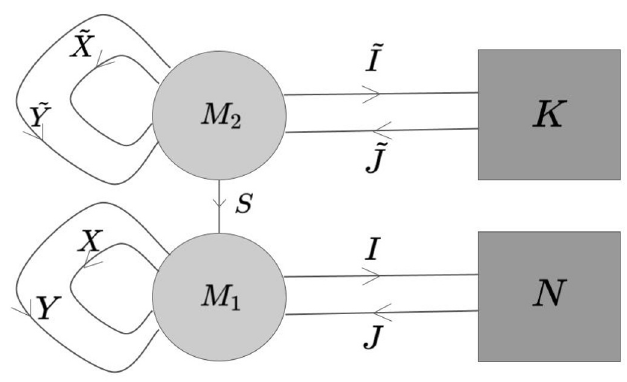
Figure 2 . The quiver for the matrix model related to the